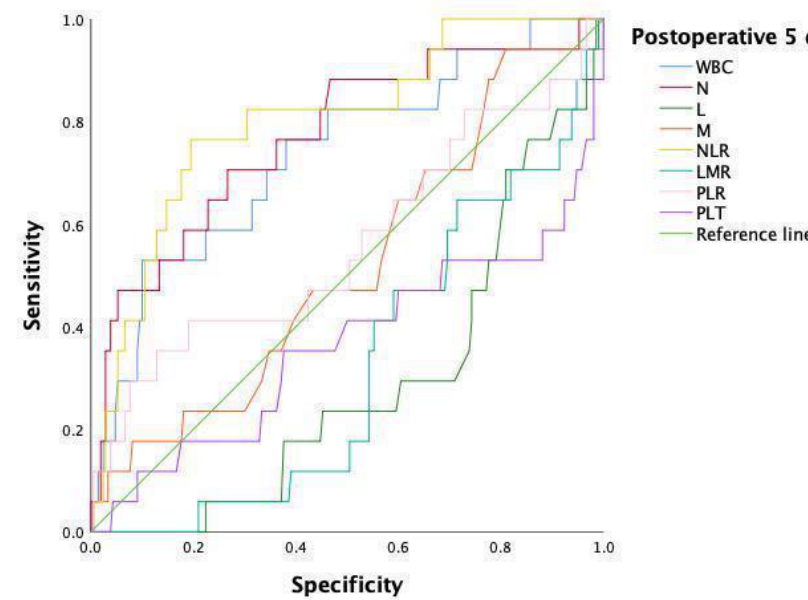
Figure 2. ROC curve before PSM analysis on day 5 after surgery.